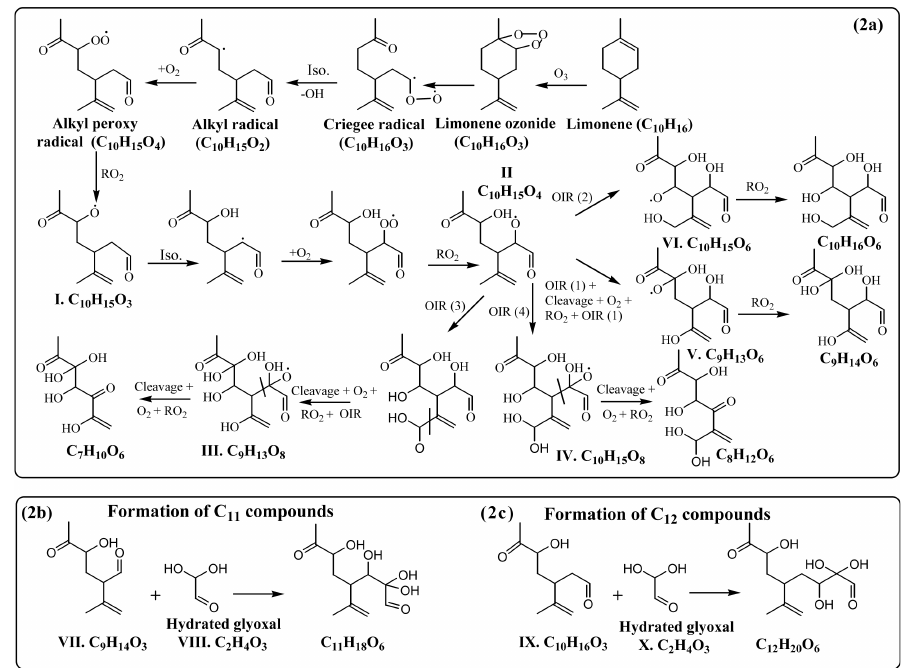
Fig. 2. Depiction of the potential formation mechanisms of CH 2 homologous series. (a) Alkoxy radical (I) resulting from the Criegee radical which undergoes oxygen-increasing-reactions (OIR, isomerization of the alkoxy radical → O 2 addition to the alkyl radical → reaction between RO 2 radicals) to become an alkoxy radical (II) with an additional oxygen atom. OIR sequence repeats to form alkoxy radicals labeled III, IV, V and VI. The number in the parenthesis beside “OIR” indicates the repetition of OIR sequence. These alkoxy radicals are converted to neutral molecules to form the homologous series. The schematics in (b, c) show organic aerosol formation for C 11 –C 12 compounds by the reactive uptake of a gas phase carbonyl (e.g., glyoxal).